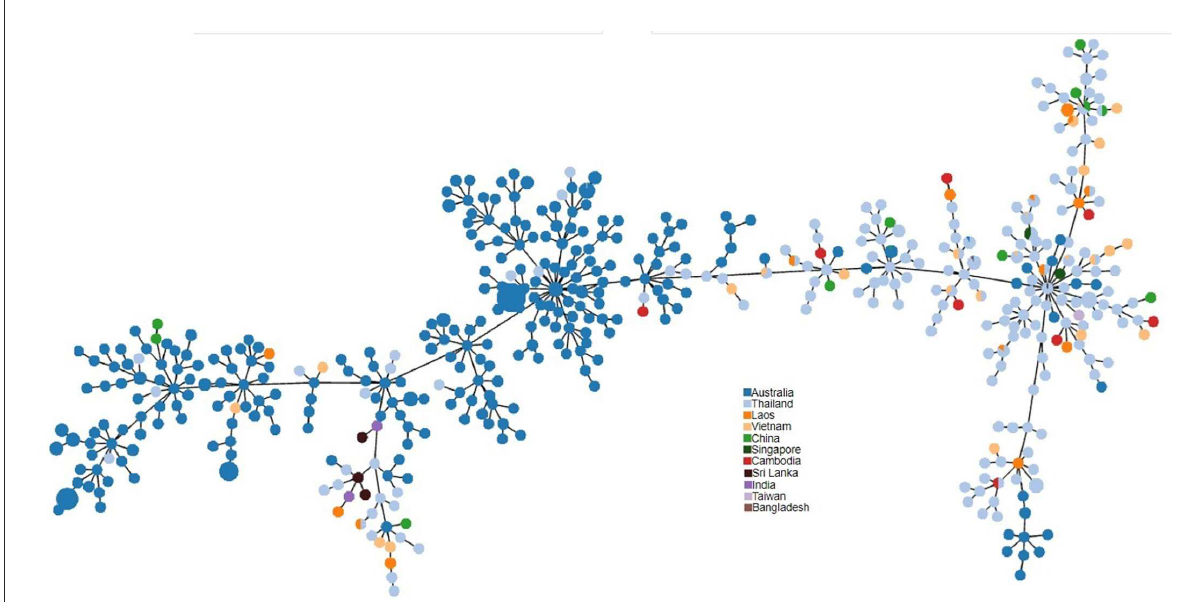
FIGURE3 PHYLOViZ analysis of STs showing the phylogenetic relationship of Sri Lankan environment isolates ( n = 3 STs) with environment isolates from Australia ( n = 220), Thailand ( n = 163), Vietnam ( n = 25), Laos ( n = 19), China ( n = 11), Cambodia ( n = 8), Singapore ( n = 4), India ( n = 2), Taiwan ( n = 1), and Bangladesh ( n =